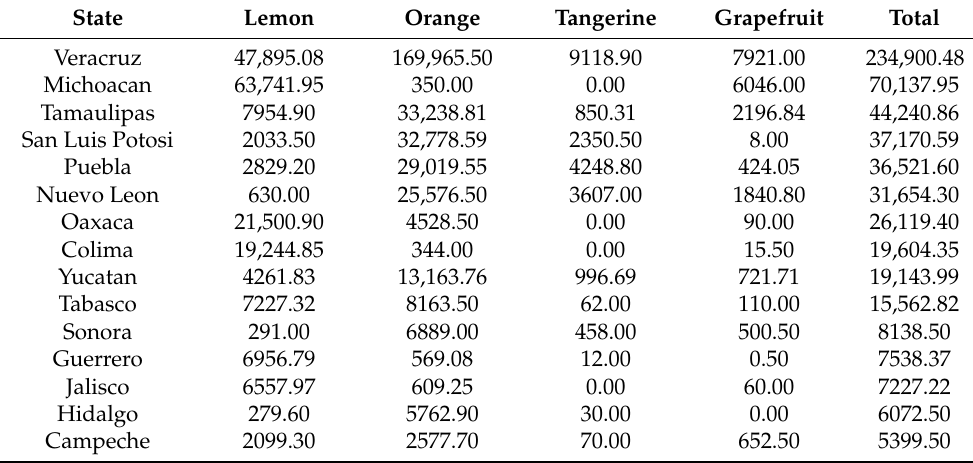
Table 1. Federal entities of Mexico and cultivated surface (hectares) with four citrus species (Made with data from